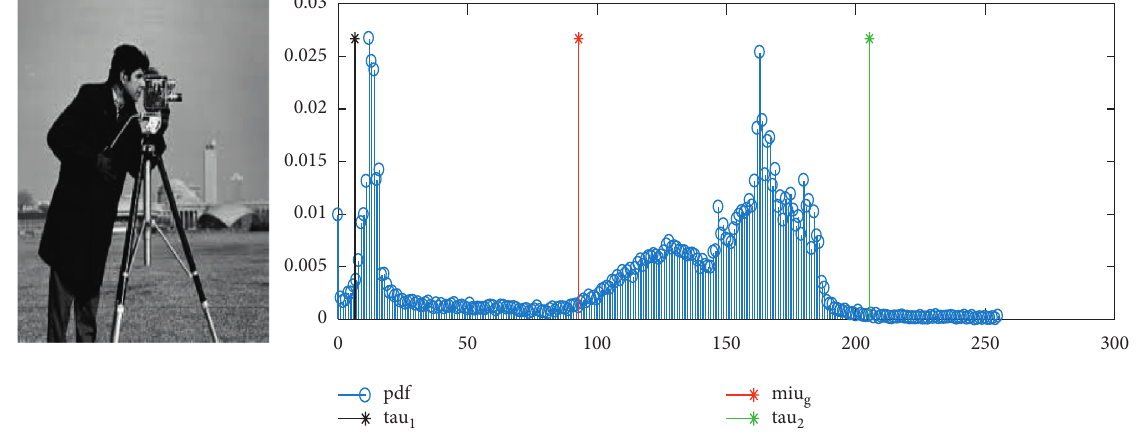
Figure 1: Cameraman image with normalized histogram and estimated bilevel